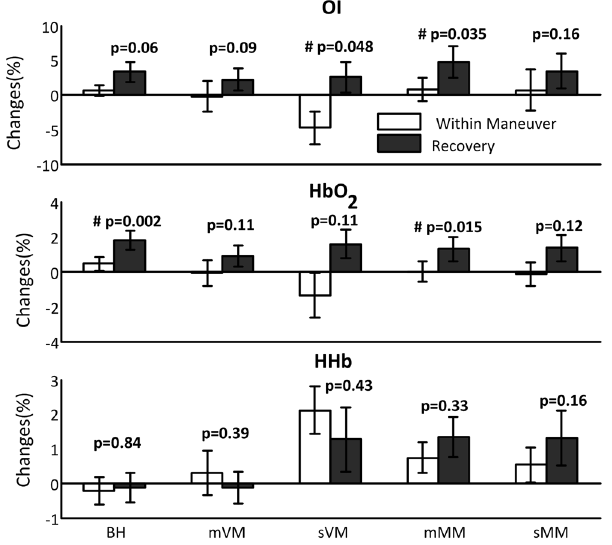
Figure 3. The changes in cerebral oxygen index (OI), HbO 2 and HHb between the periods within maneuver and recovery. # Indicates significant differences. The error bars are standard error and n = 12.